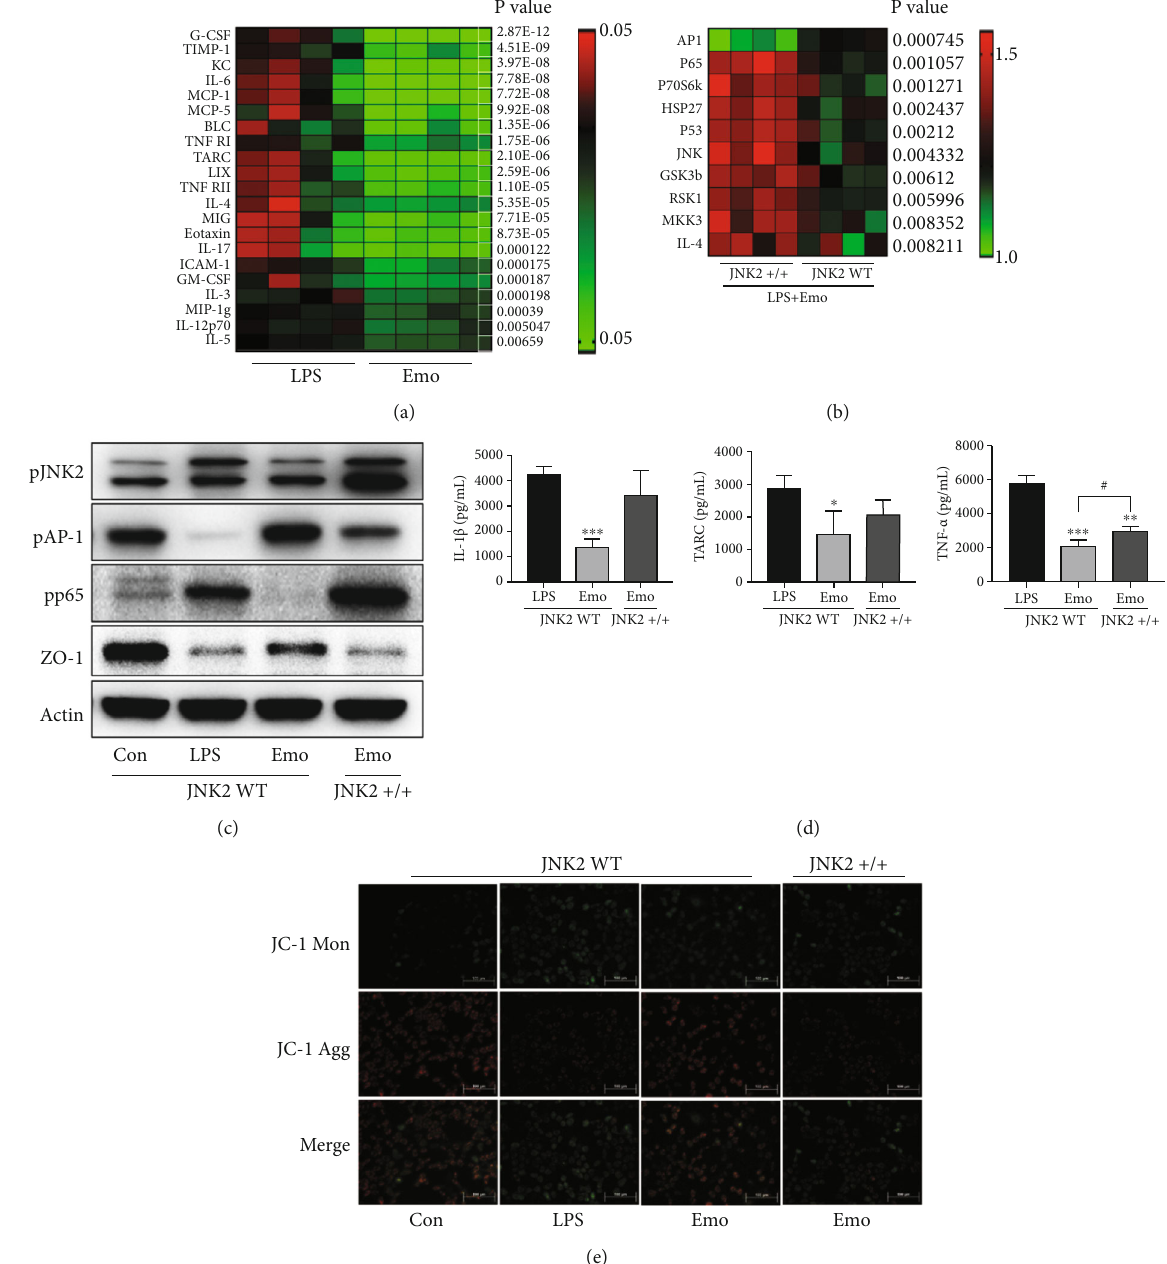
Figure 5: Role of JNK2 in emodin exhibited activities. (a) Cytokine microarray was employed for the detection of in fl ammatory cytokines. Fold changes of LPS group were indicated in the heat map, and di ff erences between mean values were assessed. p < 0 : 05 indicates signi fi cant di ff erence compared with LPS group. (b) Proteins ’ phosphorylation was examined using a customized phosphorylation microarray. Fold changes of LPS group were indicated in the heat map, and di ff erences between mean values were assessed by modulated t -statistics. p < 0 : 05 indicates signi fi cant di ff erence compared between WT and JNK2 overexpressed cells. (c) WT cells or JNK2 overexpression cells were challenged, and samples of each group were obtained to detect the expression of pJNK2, pAP-1, pp65, and ZO-1 by western blot. (d) WT cells or JNK2 overexpression cells were challenged, and samples of each group were obtained for ELISA detection. Data represent the mean ± SD of three independent experiments, and di ff erences between mean values were assessed by one-way ANOVA. ∗ p < 0 : 05 , ∗∗ p < 0 : 01 , ∗∗∗ p < 0 : 001 , and # p < 0 : 05 indicate signi fi cant di ff erences compared with LPS group. (e) Detection of mitochondrial membrane potential by JC-1 staining. Cells were treated as indicated. The double staining of cells by JC-1 is visible either as green for JC1 monomers (Mon) or red for J-aggregates